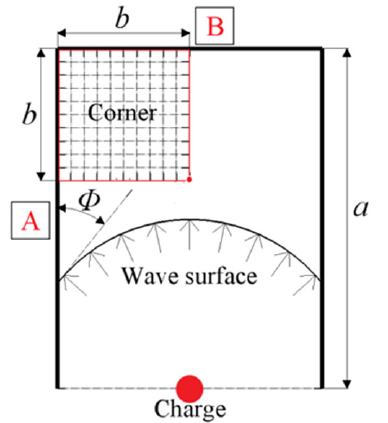
Figure 2. Two-dimensional schematic diagram of the calculation model.